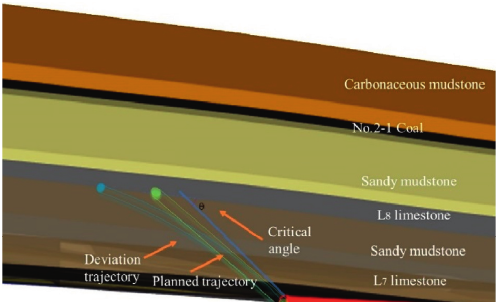
Figure 6: Comparison of stratigraphic